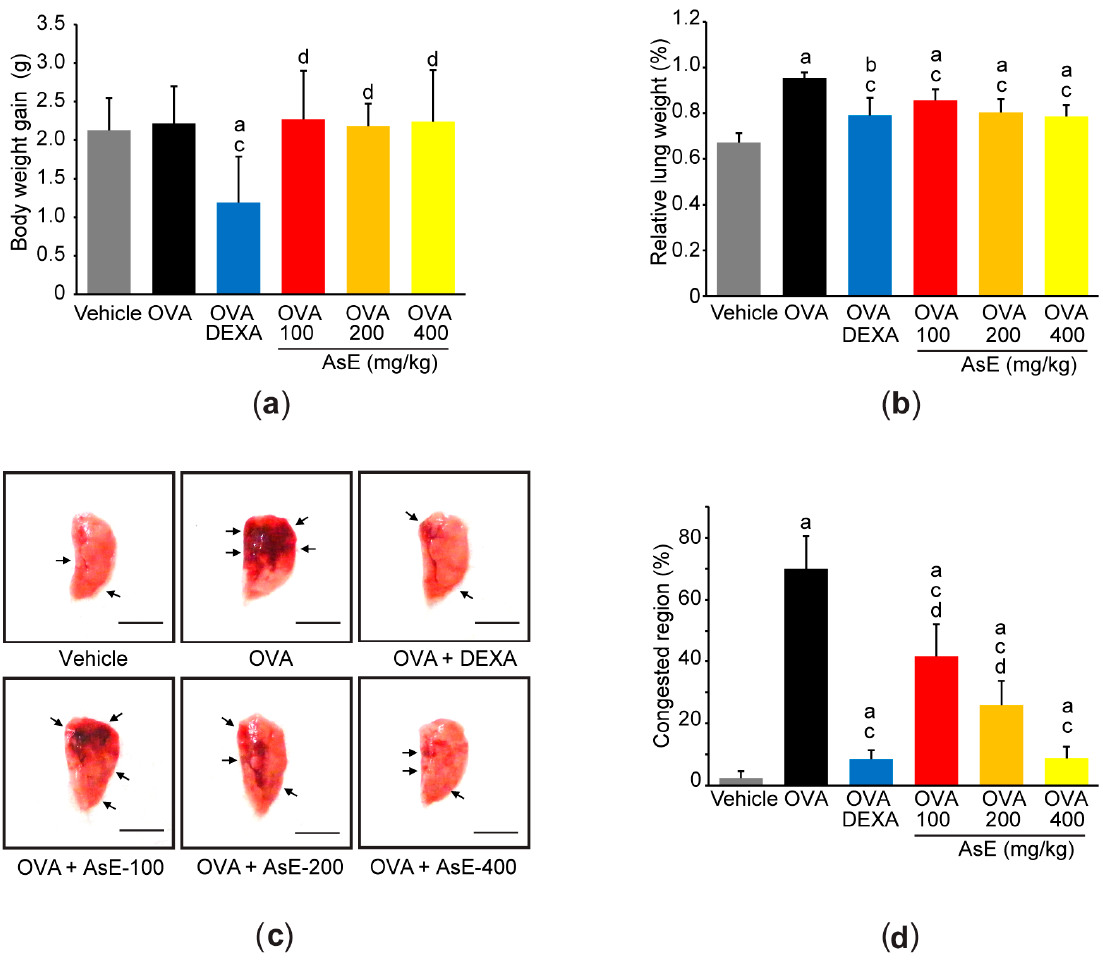
Figure 1. AsE reduces pulmonary congestion in OVA-induced allergic asthma. Body weight gain ( a ) and relative lung weight ( b ) were calculated as described in the Materials and Methods section. ( c ) Representative image of the left lung lobe. Arrows indicate the congested regions, and scale bars indicate 6.0 mm. ( d ) The congested region was calculated as the percentage of the congested area in the left lung. a p < 0.01, b p < 0.05 versus vehicle group; c p < 0.01 versus OVA group; d p < 0.01 versus OVA + DEXA group; AsE, Adenophora stricta root extract; DEXA, dexamethasone; OVA, ovalbumin.